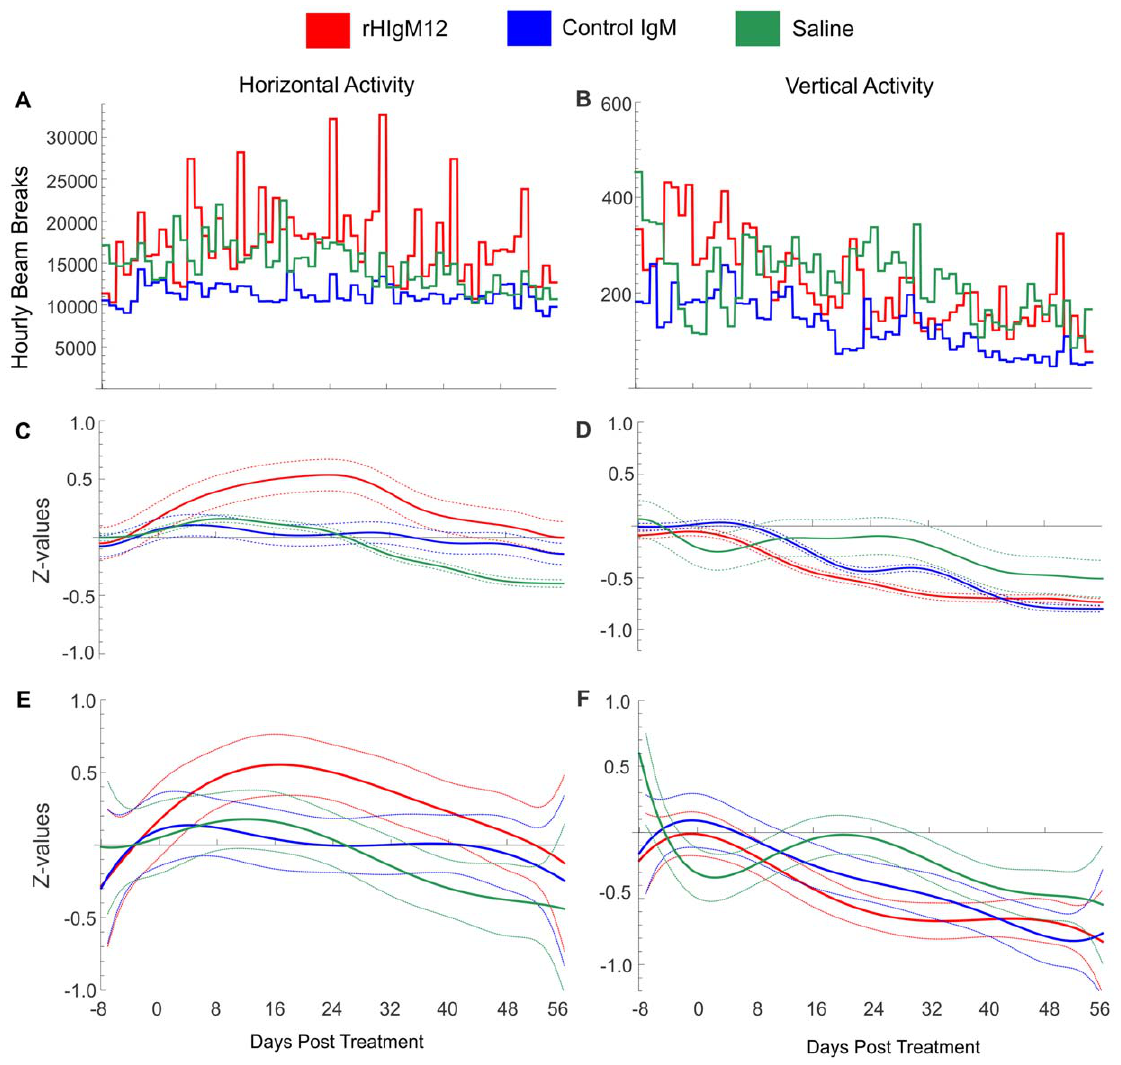
Figure 2. A single i.p. dose of neuron-binding antibody (rHIgM12) improves horizontal activity in chronically infected SJL mice. Three groups of 5 SJL mice at 90dpi were placed in AccuScan activity monitoring boxes. Baseline measurements were collected over 8 days. After the treatment mice were monitored continuously over 8 weeks. Panels A, C and E correspond to horizontal activity and B, D and F correspond to vertical activity. A, B) Average nocturnal activities presented as bins for each day suggested the improvement in horizontal activity only in rHIgM12-treated group; C) Gaussian filtering (GB=2 days) and E) 6 th order polynomial fitting of standardized Z-values provided a clear and distinct improvement in rHIgM12-treated mice. B, D and F) Vertical activity was not affected by any treatment. Activity (vertical scale) is the number of beam interruptions per hour. Parameter GB can be interpreted as a value (in days) of the filter half width at the half height. With the increase of GB value the standard deviation decreases. The pointwise 95% confidence bands are given for each